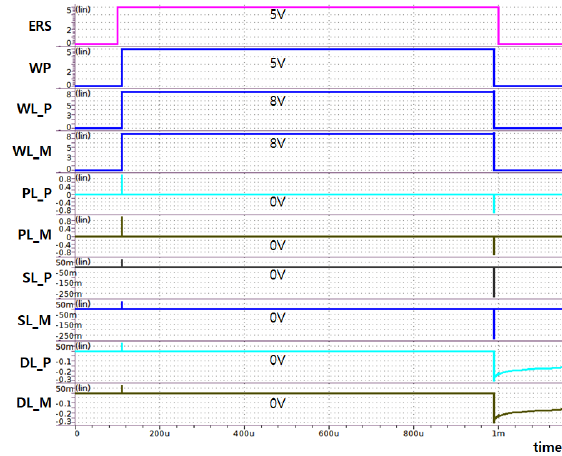
Figure 16. Simulation result for the erase mode.